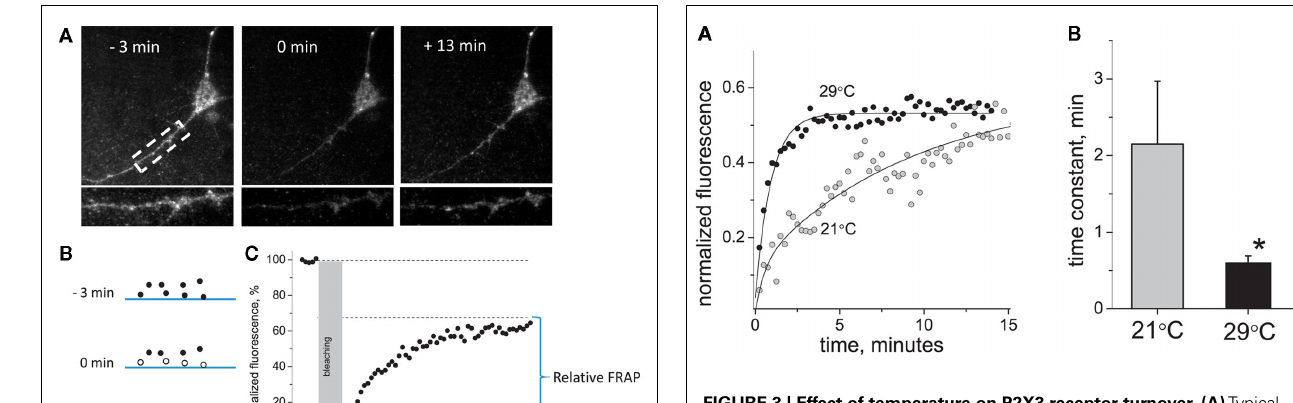
FIGURE 3 | Effect of temperature on P2X3 receptor turnover. (A) Typical examples of P2X3-DsRed fluorescence recovery traces at 21˚C (tau = 3.5min) and 29˚C (tau = 0.9min). (B) Averaged time constant of P2X3 receptor recovery at 21˚C ( n = 12) and 29˚C ( n = 16).The asterisk denotes a significant difference at P < 0.05.